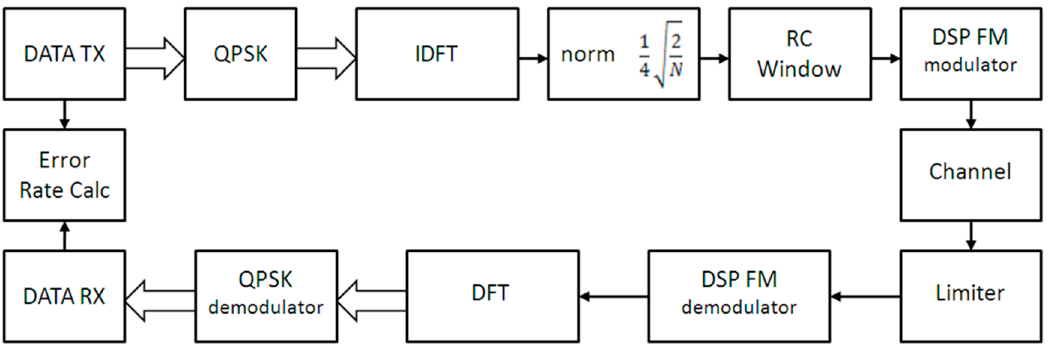
Figure 1. The structural scheme of the orthogonal frequency division multiplexing in combination with additional frequency modulation (FM-OFDM-QPSK) transmitting-receiving processes.